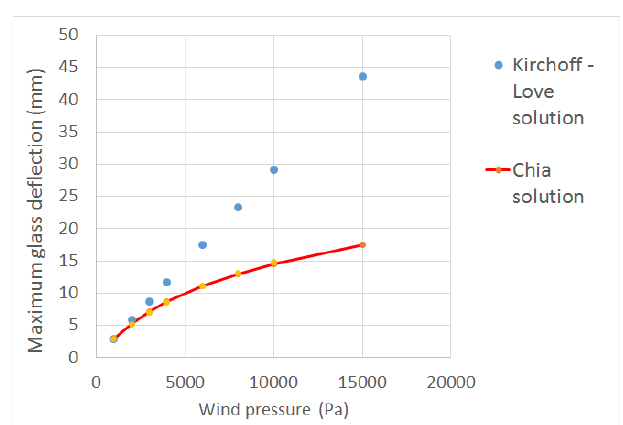
Fig 7: Comparison between the Chia solution (equation 10) of the Von Karman equation of an isotropic plate submitted to a transverse load and the approximated Kirchhoff-Love solution (equation 7) We observe that for a glass deflection of 10mm corresponding to 1% of glass deflection, the deflection calculated by using the KL approximated solution is overestimated by 30% and for a 2% of deflection, it is even overestimated by 60%. For this reason, in a simplified method of joint calculation, the Kirchhoff-Love solution should not be used to calculate the angle of rotation α at the edge of the plate because of its narrow domain of validity. Hence, the solution proposed by Chia will be preferred in the current